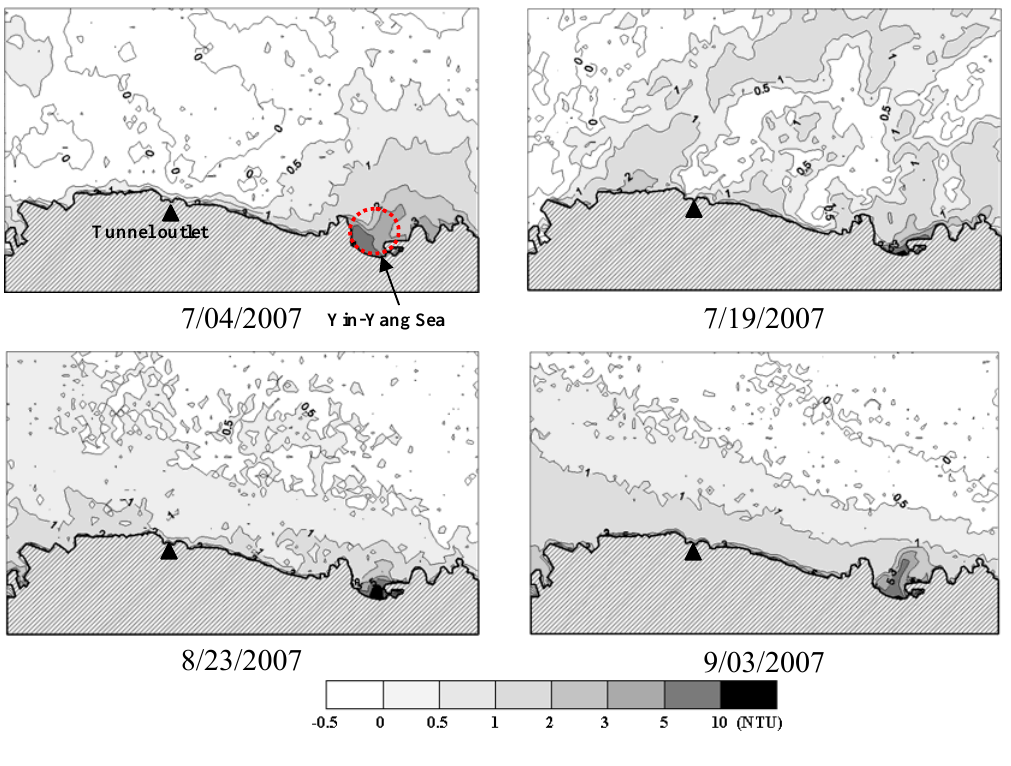
Figure 9. Spatial distribution of turbidity.